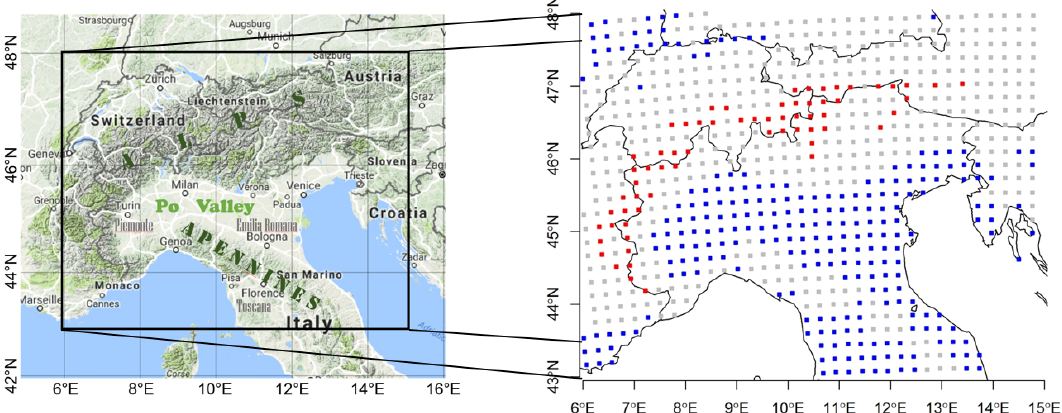
Figure 1. Geographic map ( left ; from Google Maps) in which the black box indicates a computational domain ( right ) with a total of 720 grid points for the UTOPIA model run. The elevation ( h ) of blue grid points is h ≤ 500 m a.s.l. (plain area), whereas that of red grid points is h > 2000 m a.s.l. (high-mountain area). The grey grid points represent normal mountains with an elevation between 500 and 2000 m